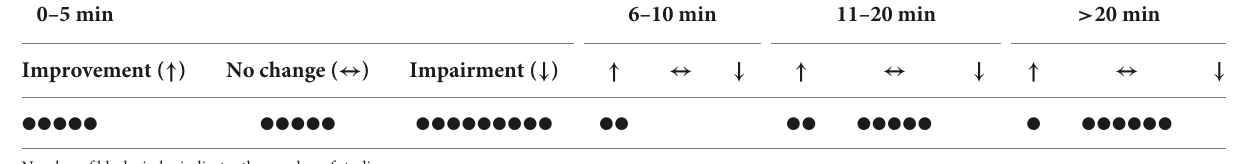
TABLE 2 Summary of impacts of time delay after exercise.